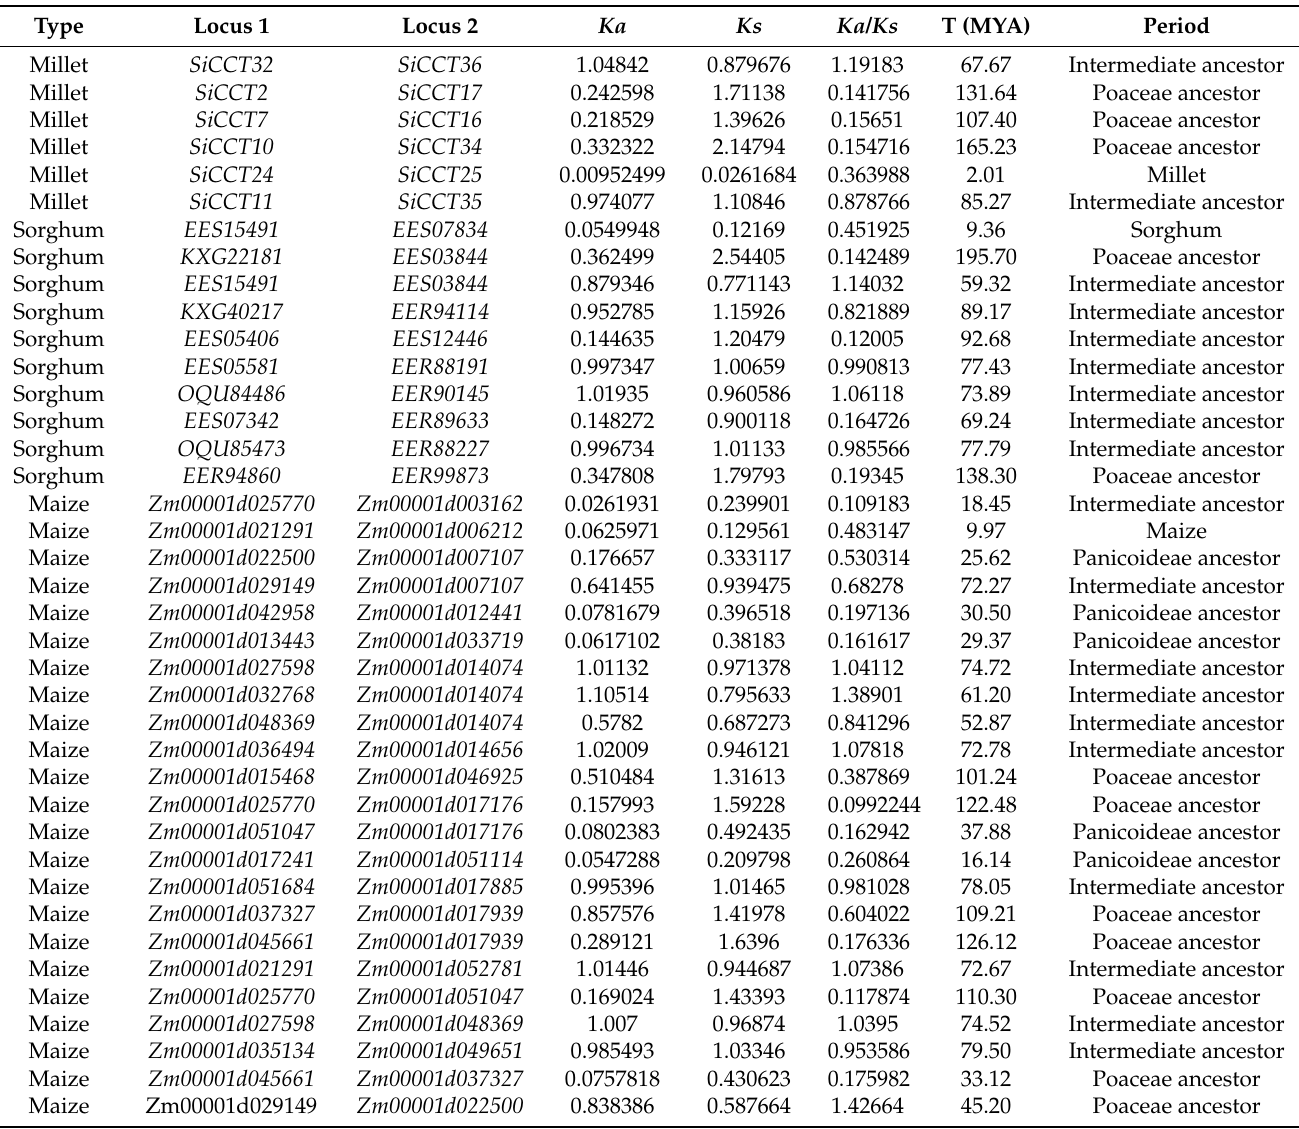
Table 2. Evolutionary analysis of SiCCT